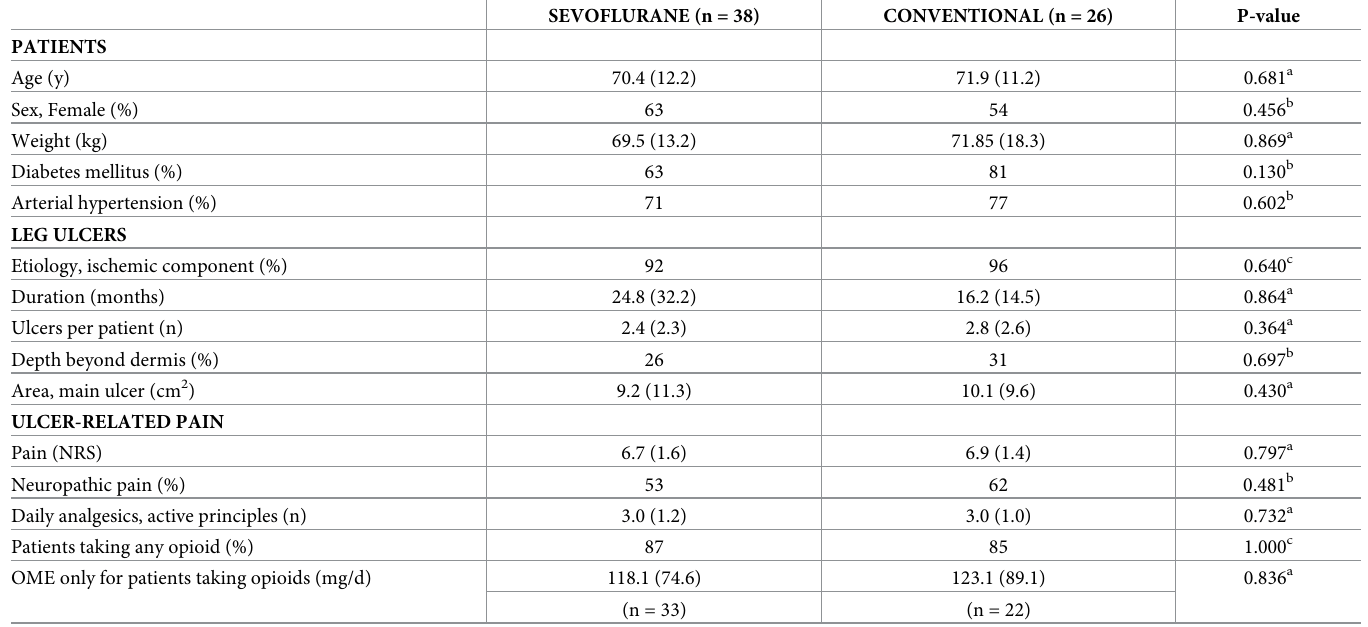
Table 1. Baseline